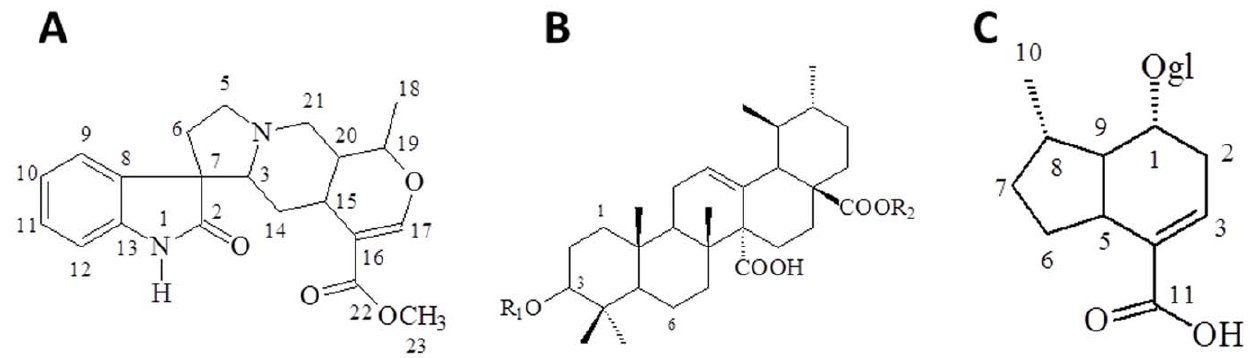
Figure 2. Chemical structures of some of the compounds relevant to this study. (A) Structure of the major alkaloids of U. tomentosa . The individual compounds differ in configuration at C-3, C-7, C-15, C-19 and C-20. (B) Structure of quinovic acid (R=H) and its glycosides (R=several sugars), as well as (C) of 7-deoxyloganic acid, all of them isolated from U. tomentosa .